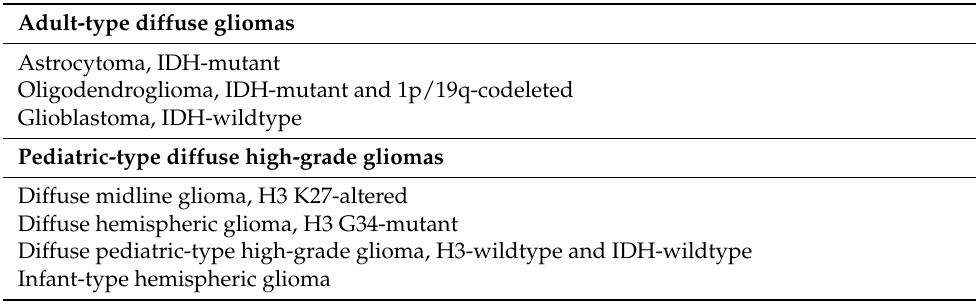
Table 1. Adult- and pediatric-type high-grade gliomas according to the 2021 WHO classification of Tumors of the Central Nervous